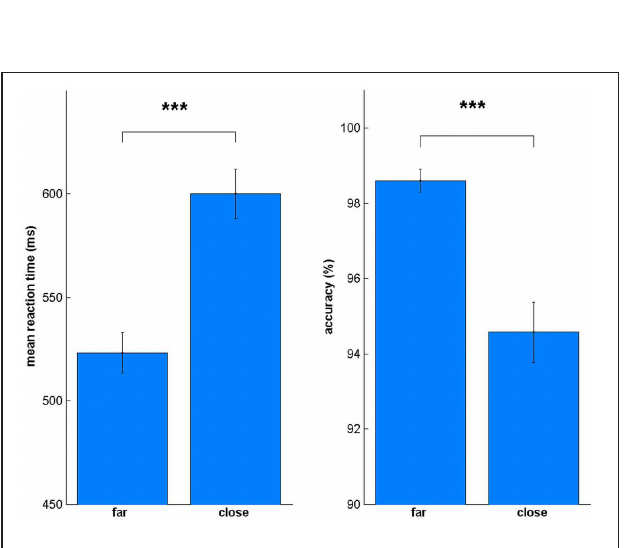
FIGURE 4 | Distance effect for reaction time and accuracy. In all sessions, close numbers were solved significantly slower and less accurate. ∗∗∗ p < 0 . 001.